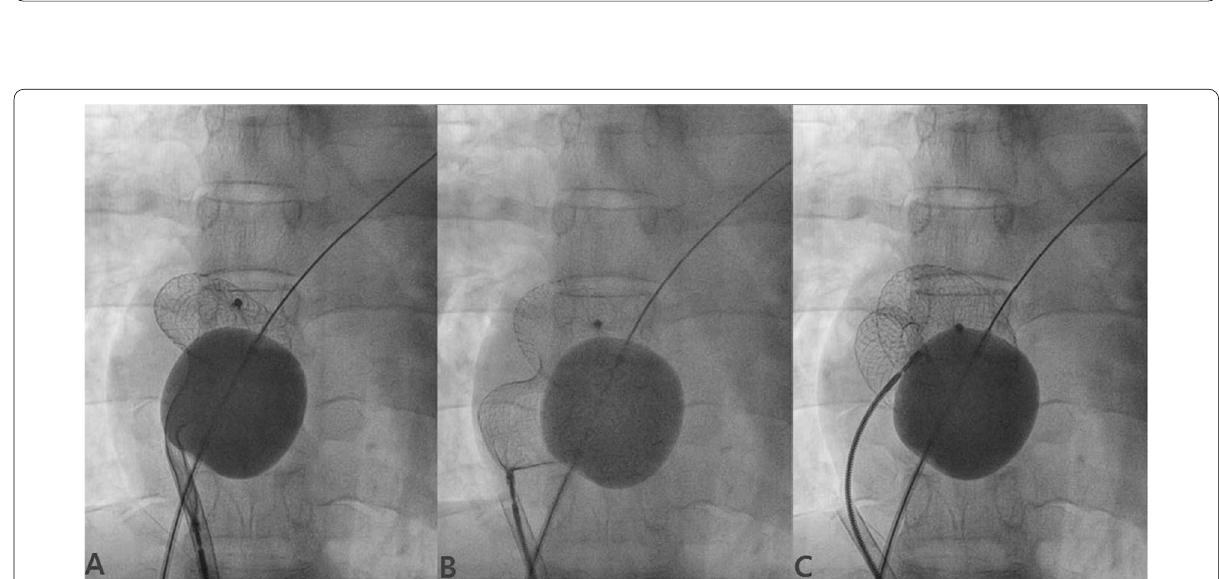
Fig. 7 Device deployment using BAT technique. ( A Equalizer balloon was inflated in RA touching the septum over the wire which was parked in LUPV, while the sheath was placed over the wire parked in RUPV; B left disk was partially opened just outside RUPV; C sheath was quickly pulled to open its remaining part)